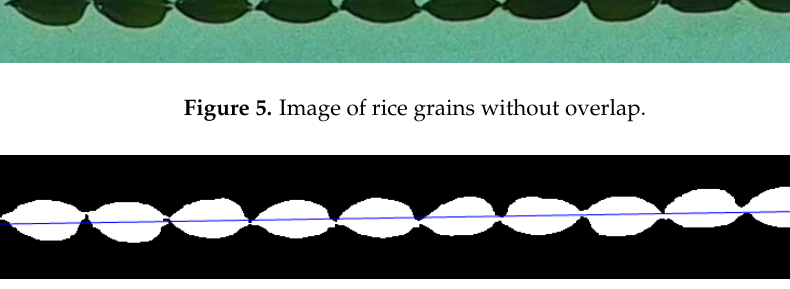
Figure 7. The waveform of the contour sequence and waveform after 8–16 Hz reconstruction.